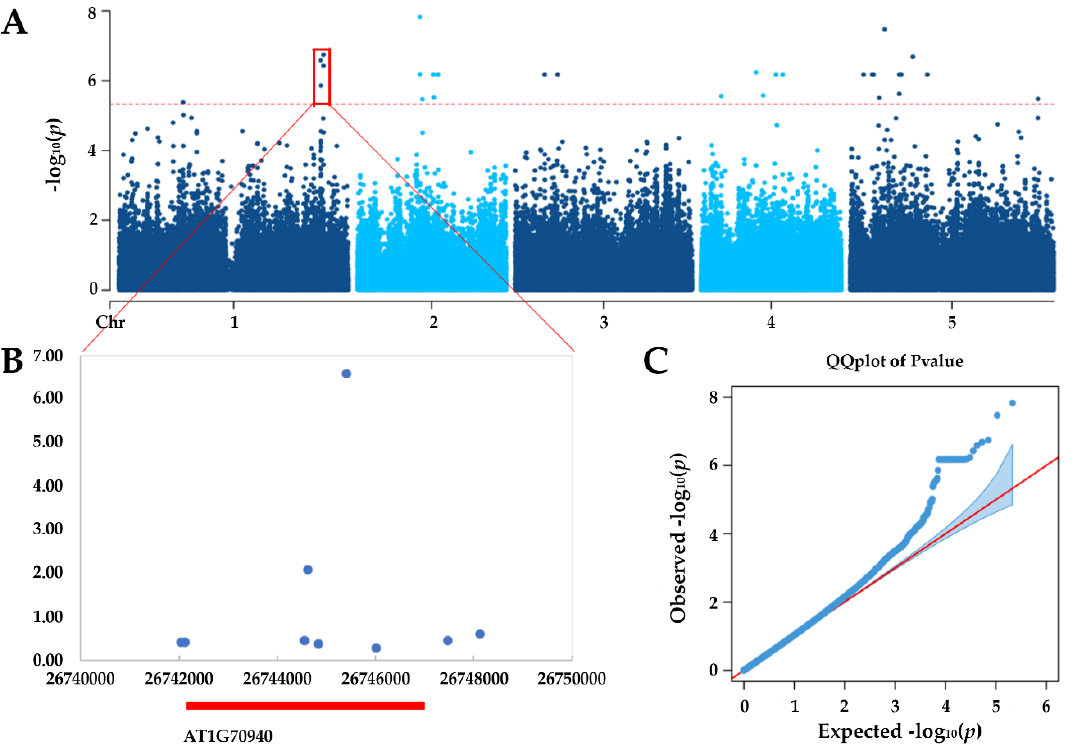
Figure 2. Genome-wide association studies (GWAS) of seed number per silique (SNS) in Arabidopsis . ( A ) Manhattan plots of the Fast-LMM model. Red dashed line corresponds to–log10 ( p -values) > 5.327. ( B ) Local region of significant GWAS signal with predict gene annotation show GWAS signals concentrate upon PIN3 gene. ( C ) Q-Q plot of the Fast-LMM mode.